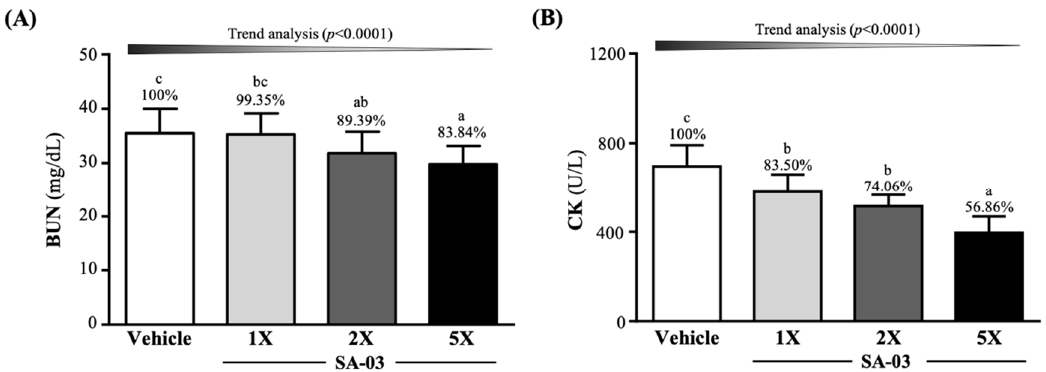
Figure 5. Effect of 4 weeks of SA-03 supplementation on serum ( A ) BUN and ( B ) CK levels after 90-min swimming exercise and 60-min rest. Data are expressed as mean ± SD ( n = 10 mice per group). Different superscript letters (a, b, c) indicate significant difference at p < 0.05. CK levels, an exercise injury index, were found to be decreased by 16.50% ( p = 0.0019), 25.94% ( p < 0.0001), and 43.14% ( p < 0.0001), respectively, in SA-03-1X, SA-03-2X, and SA-03-5X groups compared to the vehicle control